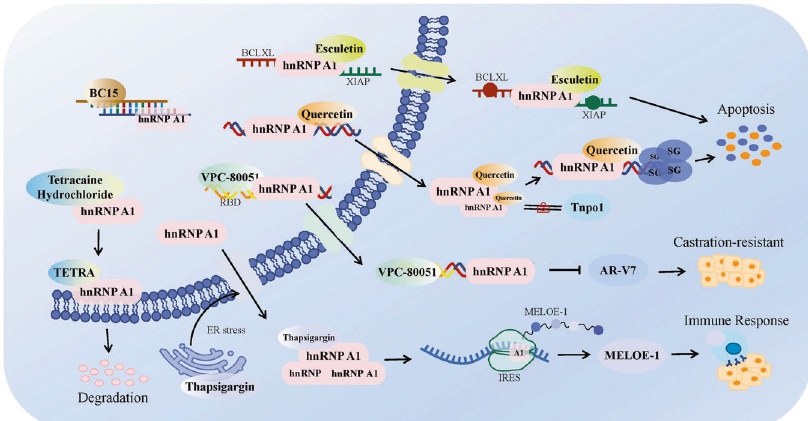
Fig. 3 Advances in drugs targeting hnRNPA1. HnRNPA1 was identi fi ed as a great target for cancer therapy and a variety of hnRNPA1- targeting compounds were attempted to applied into clinic, including small molecule inhibitor VPC-80051, plant-extracted fl avonoid quercetin, coumarin derivative esculetin, single-stranded DNA aptamer BC15 and even local anesthetic